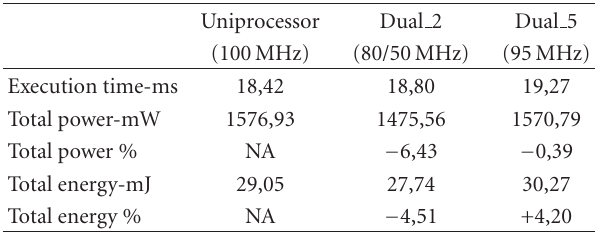
Table 13: Quicksort power and energy consumption.